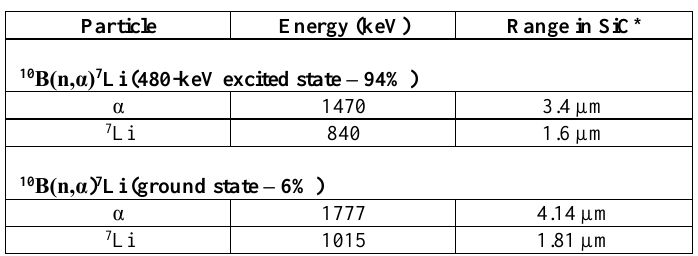
Table 1 Calculated Ranges in Silicon Carbide for 10 B